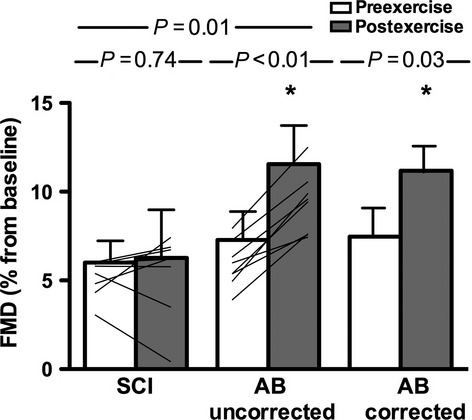
Relative flow-mediated dilation responses to arm-crank exercise intervention. Relative flow-mediated dilation (RFMD) before and after the arm-crank exercise intervention in SCI and AB; mean and individual data are presented. Corrected RFMD refers to covariate-adjustments for baseline diameter differences. Error bars represent standard deviation. *P-value < 0.05 preexercise versus postexercise.